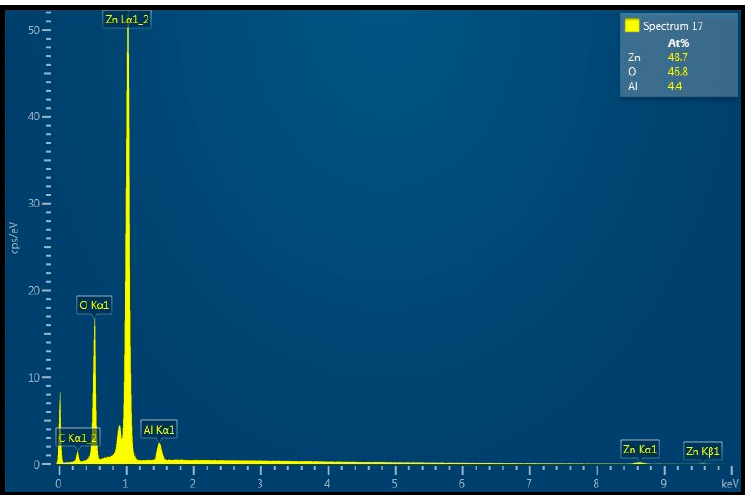
Figure 4. The EDS diagram characterizing a composition of the AZO thin film deposited by the co-sputtering method: the estimated thickness of this film was of ≈ 860 nm; after deposition, the film was annealed at temperature 500 °C through one hour at for-vacuum conditions ( ≈ 5·10 − 2 Torr). Figure 5 represents transmittance characteristics of two films with different resistiv- ity, low and high.